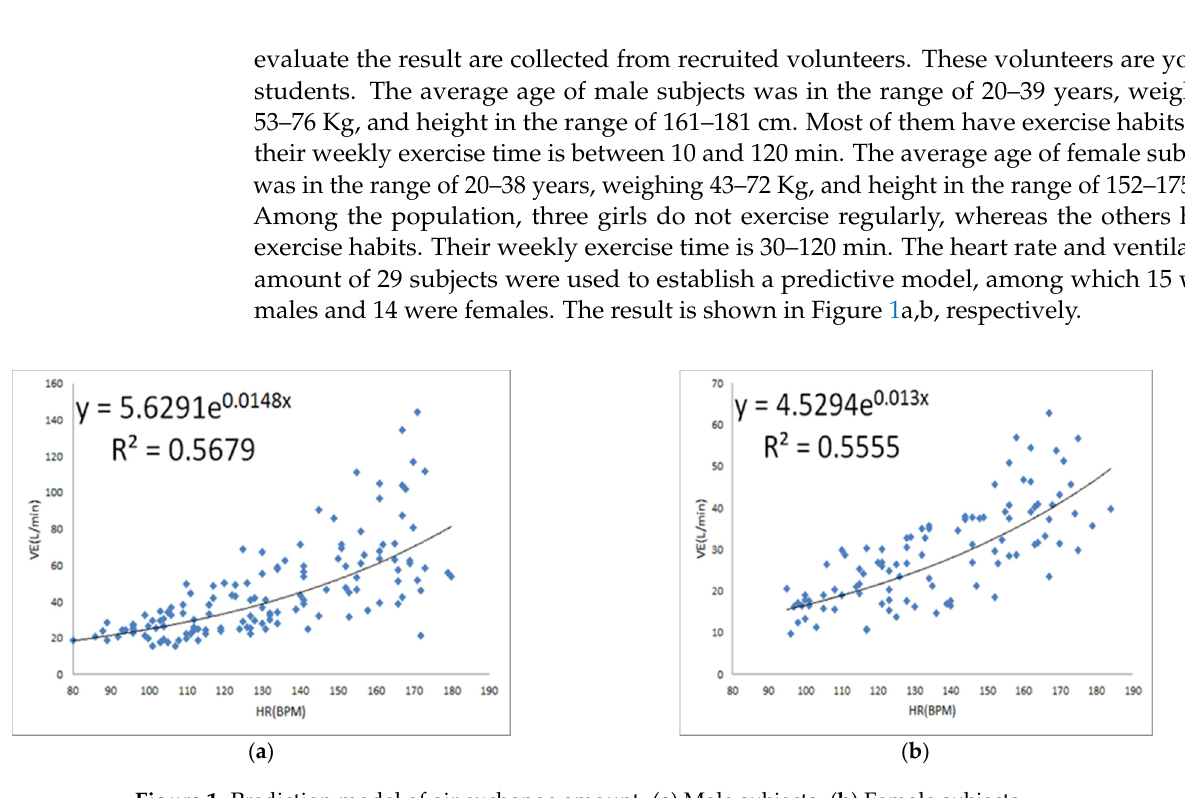
Figure 1. Prediction model of air exchange amount. ( a ) Male subjects. ( b ) Female subjects.